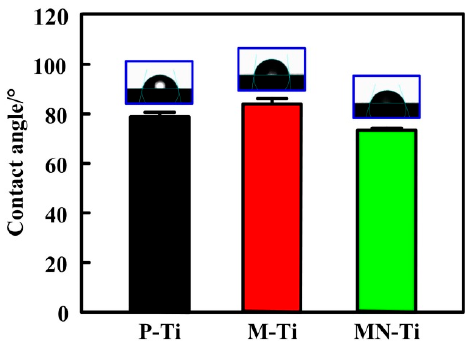
Figure 6. Water contact angles of P-Ti, M-Ti, and MN-Ti. Error bars represent means ± SD for n = 5.